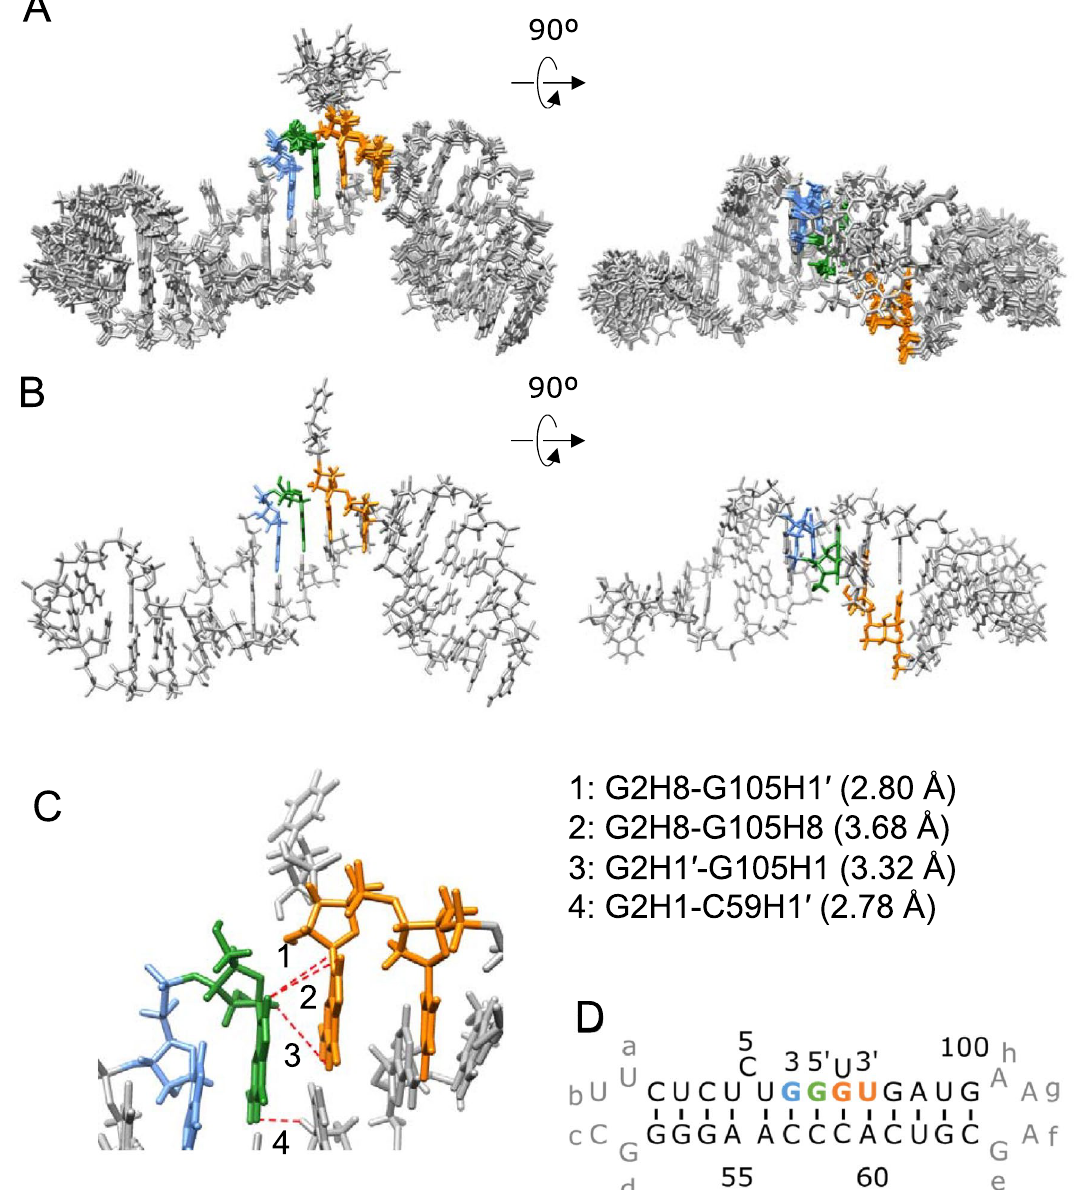
Figure 4. Solution structures of TP-G1G-36. ( A ) Superposition of the 10 accepted structures with the lowest energy. ( B ) The minimized average structures of the 10 structures. The 5 ′ -terminal G, G3 and the 3 ′ -terminal UG residues are indicated by blue, green and orange, respectively. The right panels show the 90-degree rotated views of the left panels. ( C ) Inter-stem NOEs and distances. The proton pairs are indicated by the red lines. The distances derived from the NOEs were shown. ( D ) Secondary structure of